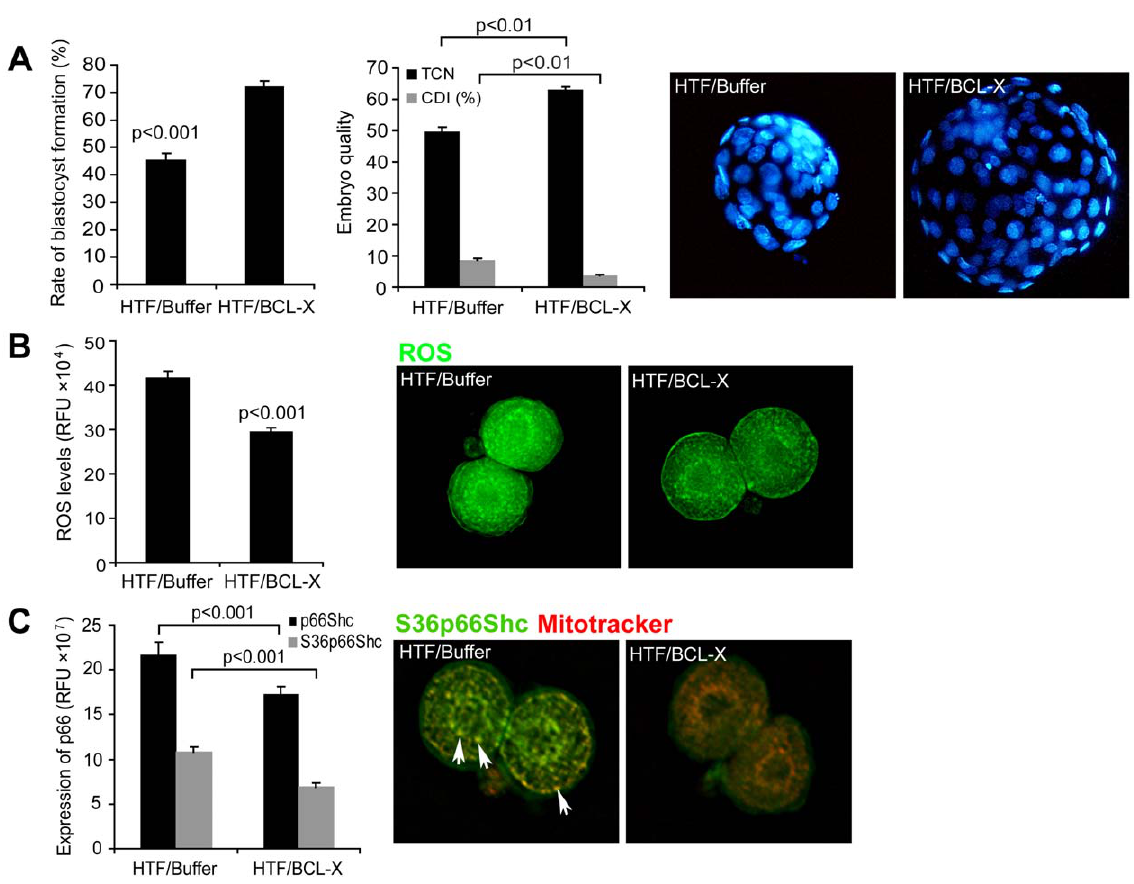
Figure 3. Impact of recBCL-XL ( D TM) microinjection on early embryo development. (A) Ability of mouse zygotes to progress through the development and form blastocysts in suboptimal HTF medium were significantly increased upon microinjection of recBCL-XL ( D TM) protein (n=424) when compared to buffer injected embryos (n=414). In addition, total cell number (TCN) per embryo was significantly increased and cell death index (CDI) was decreased (n=71 for buffer injection; n=110 for protein injection). Nuclear counterstaining (DAPI) images of blastocysts at day 4.5 reflect differences in embryo quality. Mann-Whitney U-test was used for pairwise comparison. (B) Reactive oxygen species (ROS) accumulation, determined by fluorescent measurement of DCHFDA probe fluoresce at 2-cell stage was determined 24 hours after microinjection of either buffer (n=15) or recBCL-XL ( D TM) protein (n=15) and relative fluorescence units (RFU) were used to express fluorescent signal. Injection of recBCL-XL ( D TM) significantly reduced the accumulation of ROS (student’s t-test). (C) Immunocytochemical analysis of total p66SHC or phosphorylated p66SHC on Ser36 was decreased in embryos injected with recBcl-xL ( D TM) (n=15/antibody), when compared to buffer injected embryos (n=15/antibody). In addition, we noticed that Ser10 p66SHC (green) localized to the mitochondria (Mitotracker red), with preferential clustering in subcortical and peri- nuclear regions (yellow overlap; arrows), but this was greatly reduced in recBCL-XL ( D TM) microinjected embryos. Bars indicate mean 6 s.e.m.